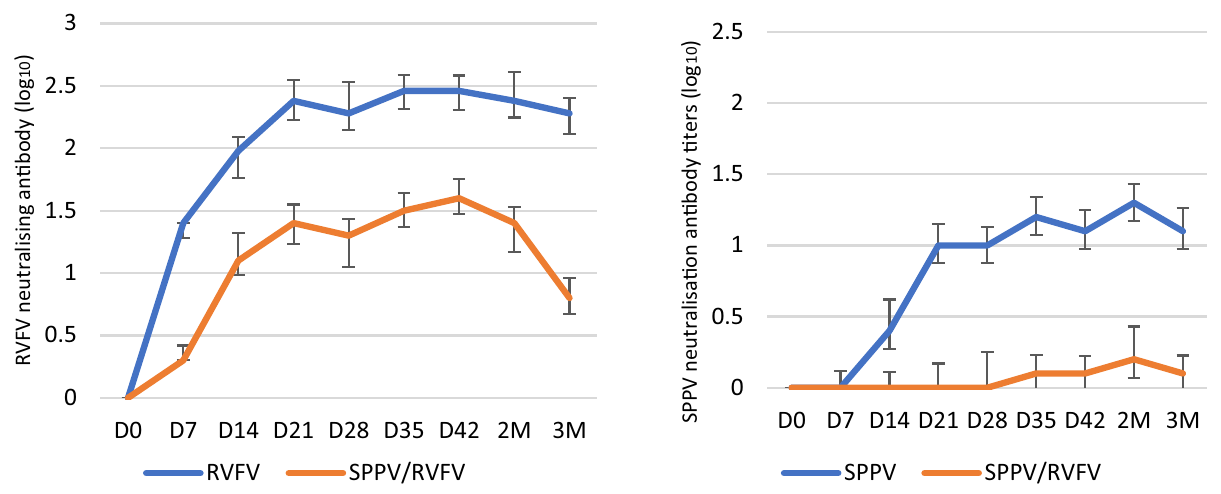
Figure 5. Antibody titers response of sheep injected with SPPV alone, RVFV alone, or with combined SPPV/ RVFV. The antibody response was determined from from D0 to 3 months pv. ( A ) Viral neutralizing antibody titers of sheep injected with RVFV and combined SPPV/RVFV ( B ) Viral neutralizing antibody titers for SPPV Monovalent and SPPV/RVFV co-infected sheep. Data shown are means of at least three neutralization experiments. D: Days M: